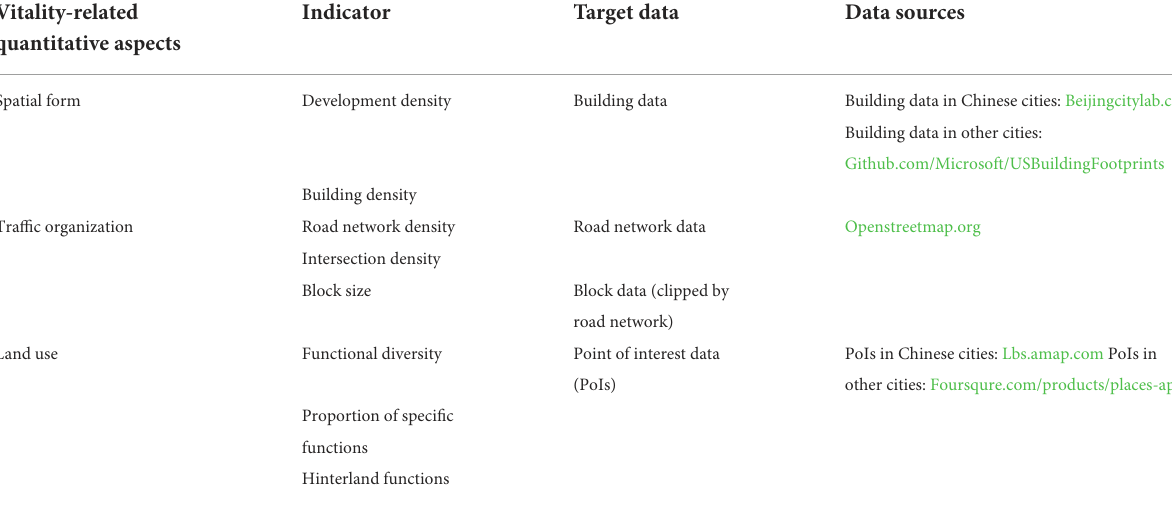
TABLE 2 Quantitative indicators and their related data